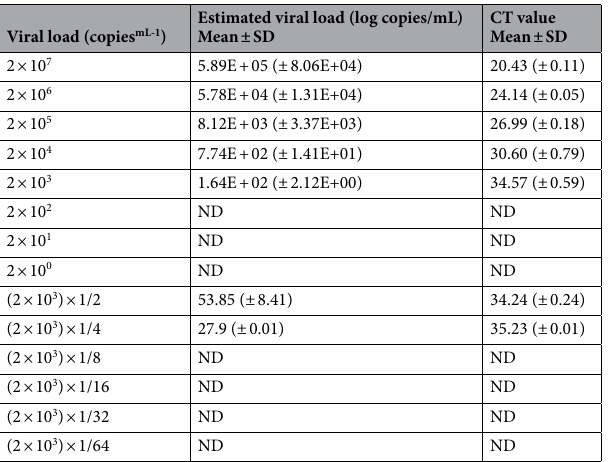
Table 2. Mean CT and estimated viral log values determined by qPCR test according to the dilution panel. The tests were conducted in duplicate to give viral load. SD standard deviation, ND not detected. * n = 2.